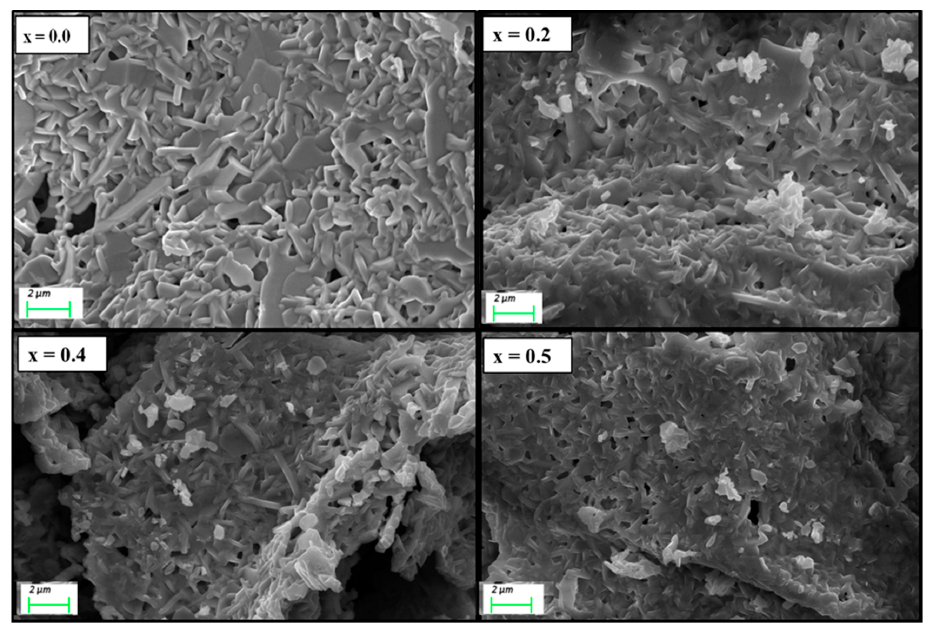
Figure 2. Scanning electron microscope (SEM) images of prepared Sr 1 − x Mn x Fe 12 − x Y x O 19 (x = 0.0, 0.2, 0.4, and 0.5) nanohexaferrites.